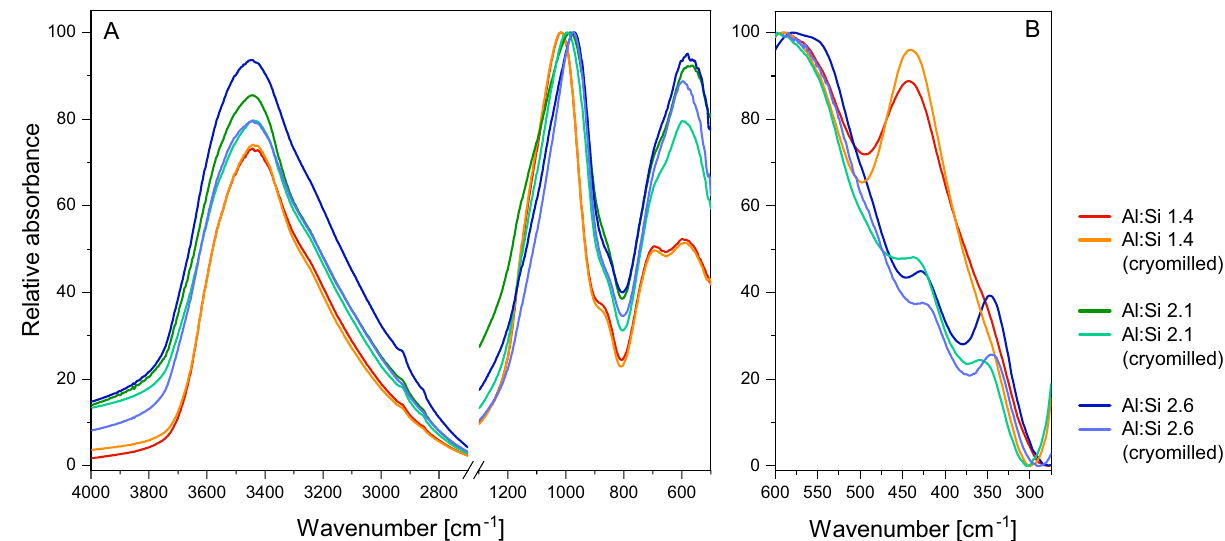
Figure 4. Fourier-transform infrared spectra of short-range ordered aluminosilicates recorded in transmission